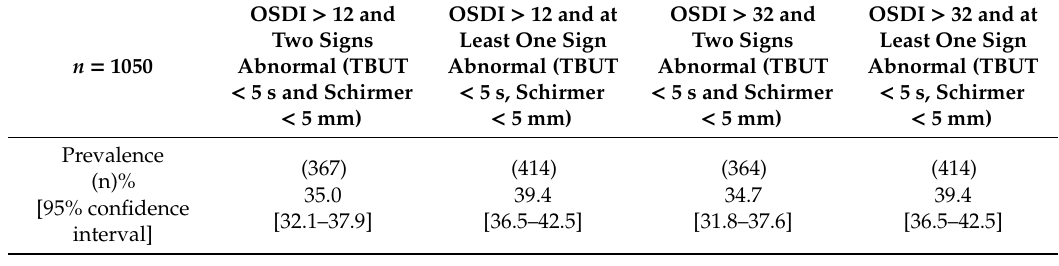
Table 1. Prevalence of dry eye in factory workers in Bangladesh.